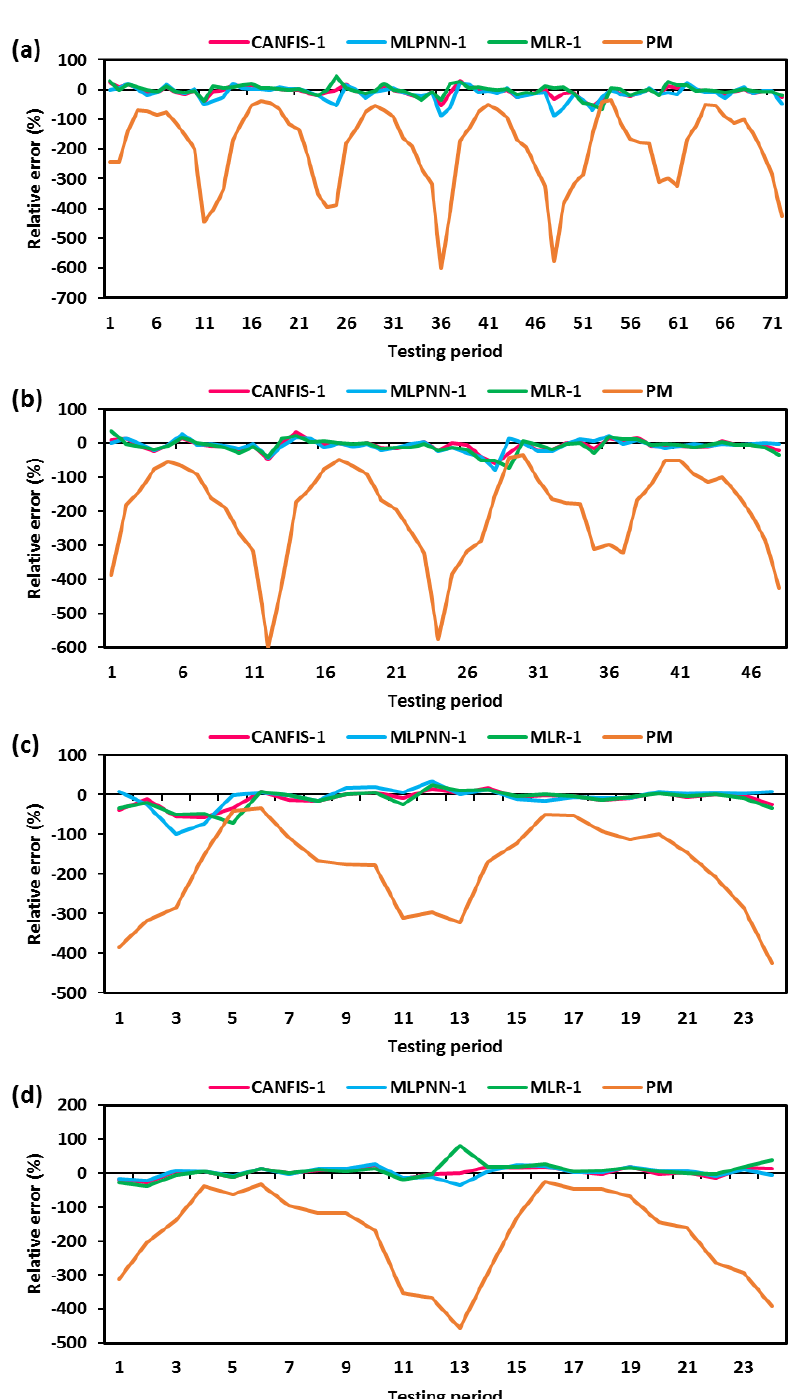
Figure 11. RE percentage distribution of the CANFIS-1, MLPNN-1, MLR-1, and PM models in ( a ) scenario-1, ( b ) scenario-2, ( c ) scenario-3, and ( d ) scenario-4 during the testing period at Nagina station.